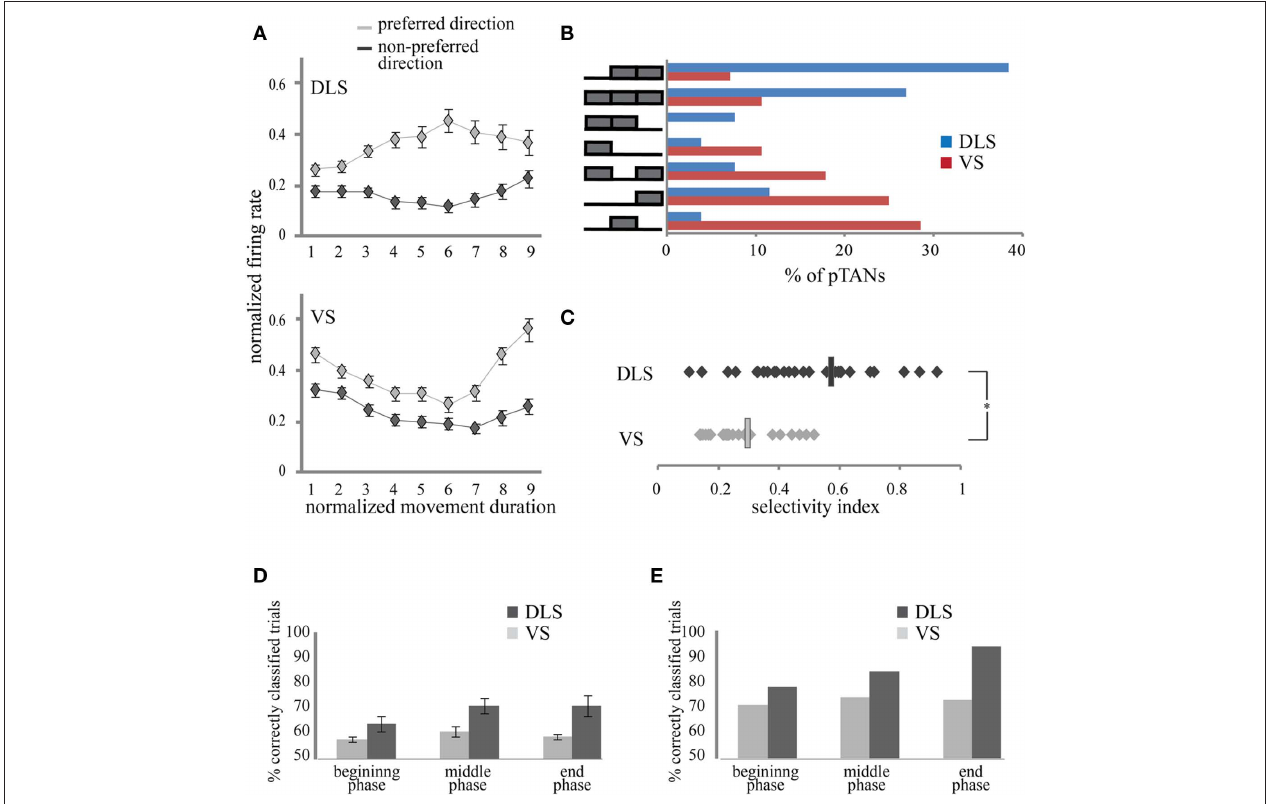
left and right firing differences during the middle and end of movement but not after movement initiation. On the right: the percent of pTANs in DLS (blue) and VS (red) assigned to each of the patterns. (C) Selectivity indices of direction selective pTANs in DLS and VS. Average values of SI are marked by rectangles. (D) Percent of trials in which movement direction was correctly predicted from the activity of single neurons, averaged over animals. Error bars are standard error of the means. (e) Percent of trials predicted correctly by the best neurons in each